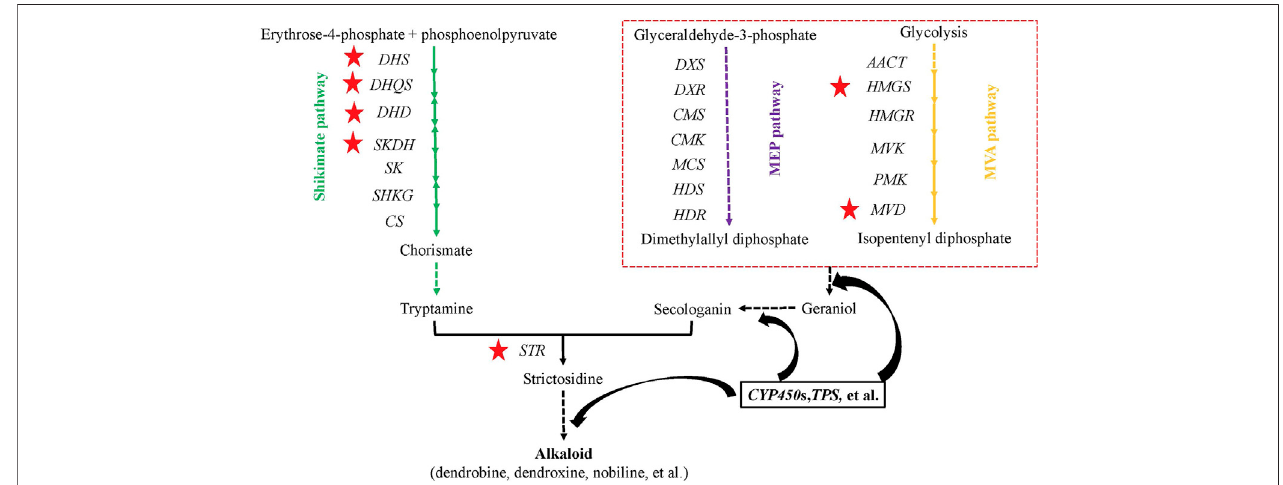
FIGURE 8 | Genes upstream of the alkaloid biosynthesis pathway in Dendrobium nobile, adapted from Pu (Pu et al., 2021) and Wang (Wang et al., 2020). In the methylerythritol phosphate (MEP) pathway, there are seven consecutive steps catalyzed by the following enzymes: DXS, 1-deoxy-D-xylulose 5-phosphate (DXP) synthase; DXR, DXP-reductoisomerase; MCT, 2-C-methyl-D-erythritol 4-phosphate cytidylyltransferase; CMK, 4-(cytidine 5 ′ -diphospho)-2-C-methyl-D-erythritol kinase; MDS, 2-C-methyl-D-erythritol 2,4-cyclodiphosphate synthase; HDS, 4-hydroxy-3-methylbut-2-enyldiphosphate (HMBPP) synthase; and HDR, HMBPP reductase. The mevolonate (MVA) pathway contains ACCT, acetyl-coenzyme A (CoA) C -acetyltransferase; HMGS, HMG-CoA synthase; HMGR, HMG-CoA reductase; MVK, mevalonic acid kinase; PMK, phosphomevalonate kinase; and MVD, mevalonate-5-diphosphate decarboxylase. The shikimate pathway contains DHS, 3-dexoy- 7-phosphoheptulonate synthase; DHQS, 3-dehydroquinate synthase; DHD, 3-dehydroquinate dehydratase; SKDH, shikimate dehydrogenase; SK, shikimate kinase; SHKG, 3-phosphoshikimate 1-carboxyvinyltransferase; and CS, chorismate synthase. The red fi ve-pointed stars show higher gene expression in stems than in leaves. The dashed lines indicate multiple